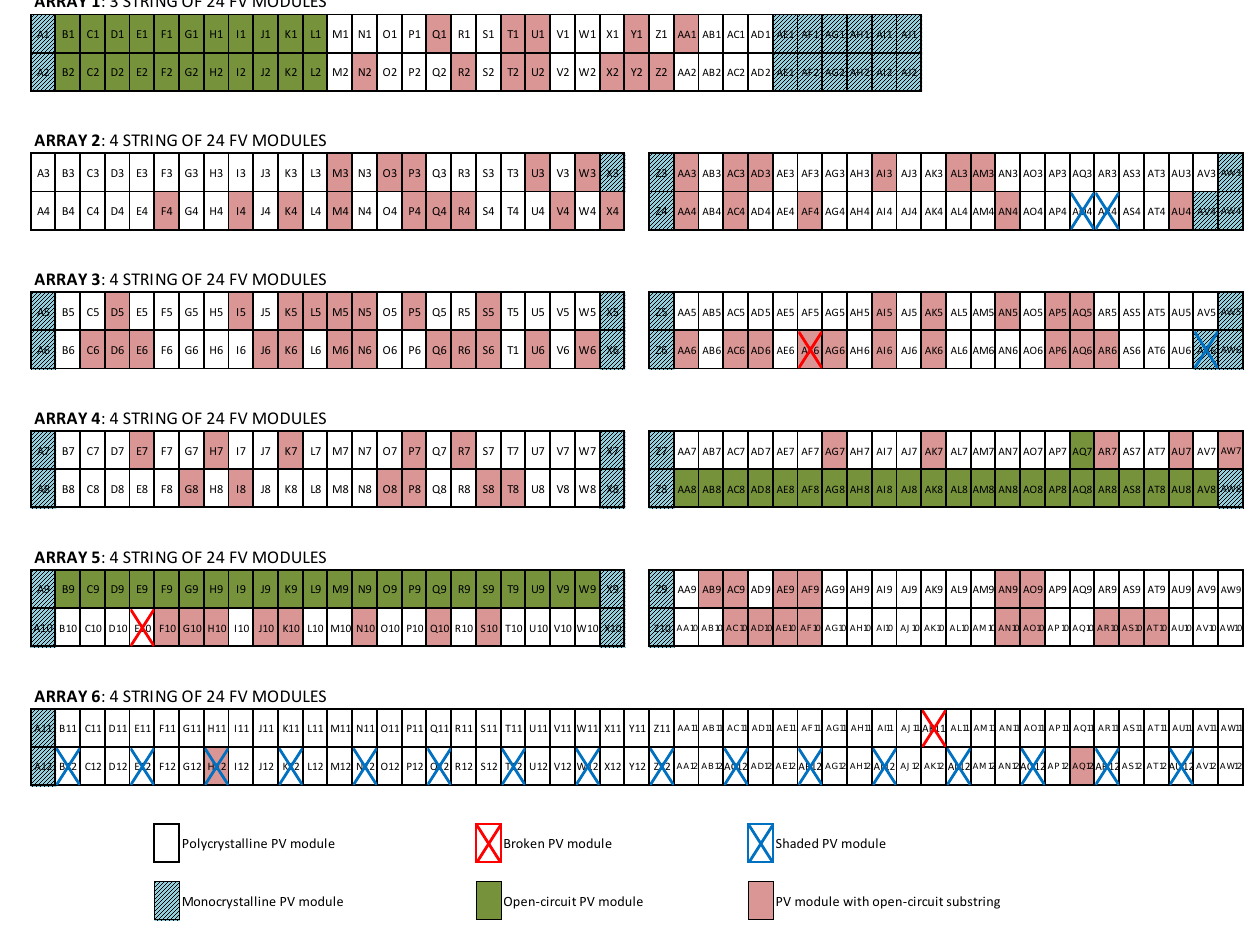
Shaded PV module